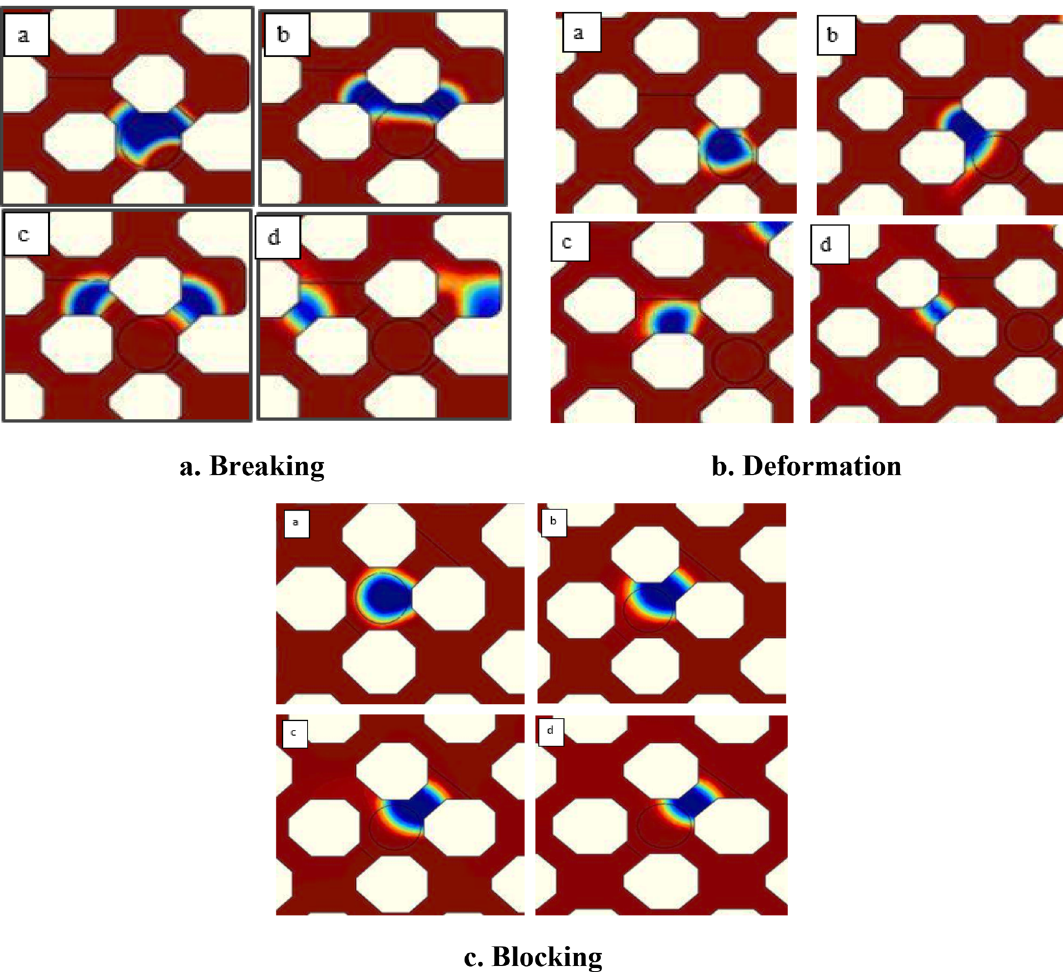
Figure 8. Mechanisms for hydrogel movement in porous